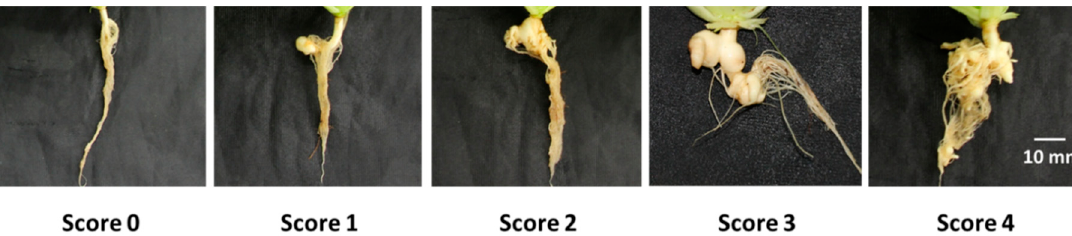
Figure 9. Scoring criteria for clubroot development in Chinese cabbage cultivar “Bullam-3-ho.” Scale of 0–4: 0 = root system without clubs, 1 = one or a few small clubs <5 mm in diameter on lateral